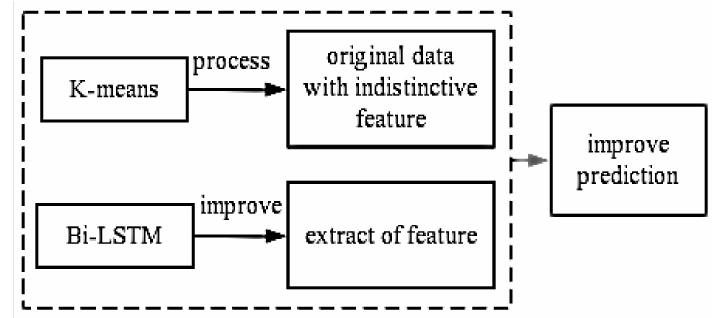
Figure 1. Methodological ideas.